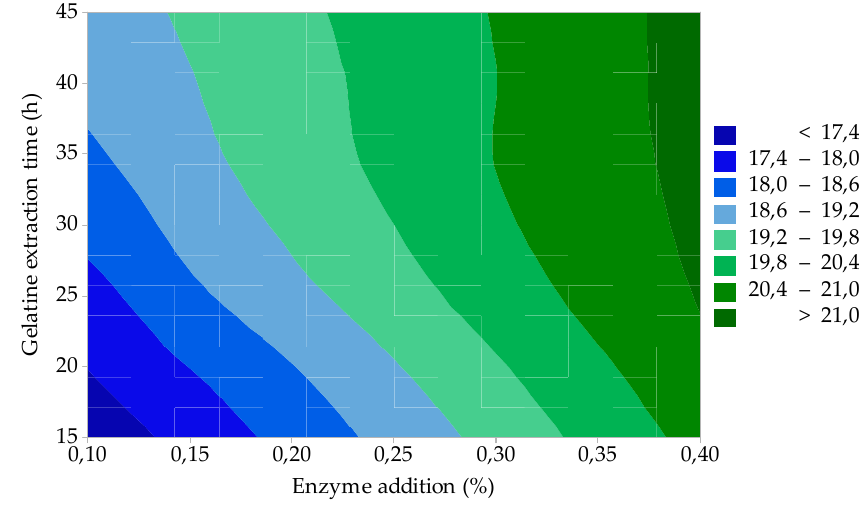
Figure 5. E ff ect of enzyme addition and gelatine extraction time on gelatine yield (process Figure 5. Effect of enzyme addition and gelatine extraction time on gelatine yield (process optimization).